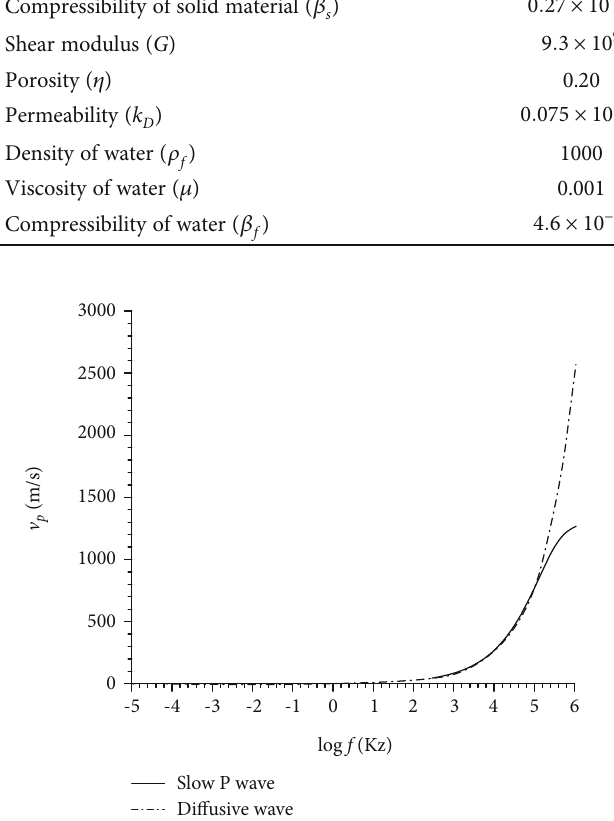
fl uid pressure wave between Biot Figure 2: Phase velocity ( v p ) of [11] theory and storativity equation (10), for water-saturated Berea sandstone and with f denoting